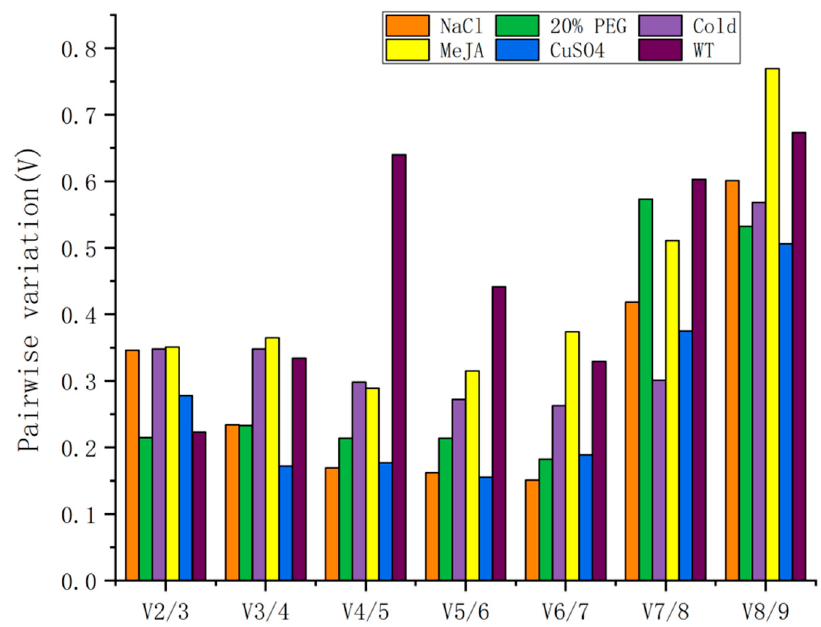
Figure 3. Pairwise variation result given by geNorm. The V -values were calculated by normalization factors NF n and NF n + 1 , suggesting the optimized number of required reference genes for normalization.